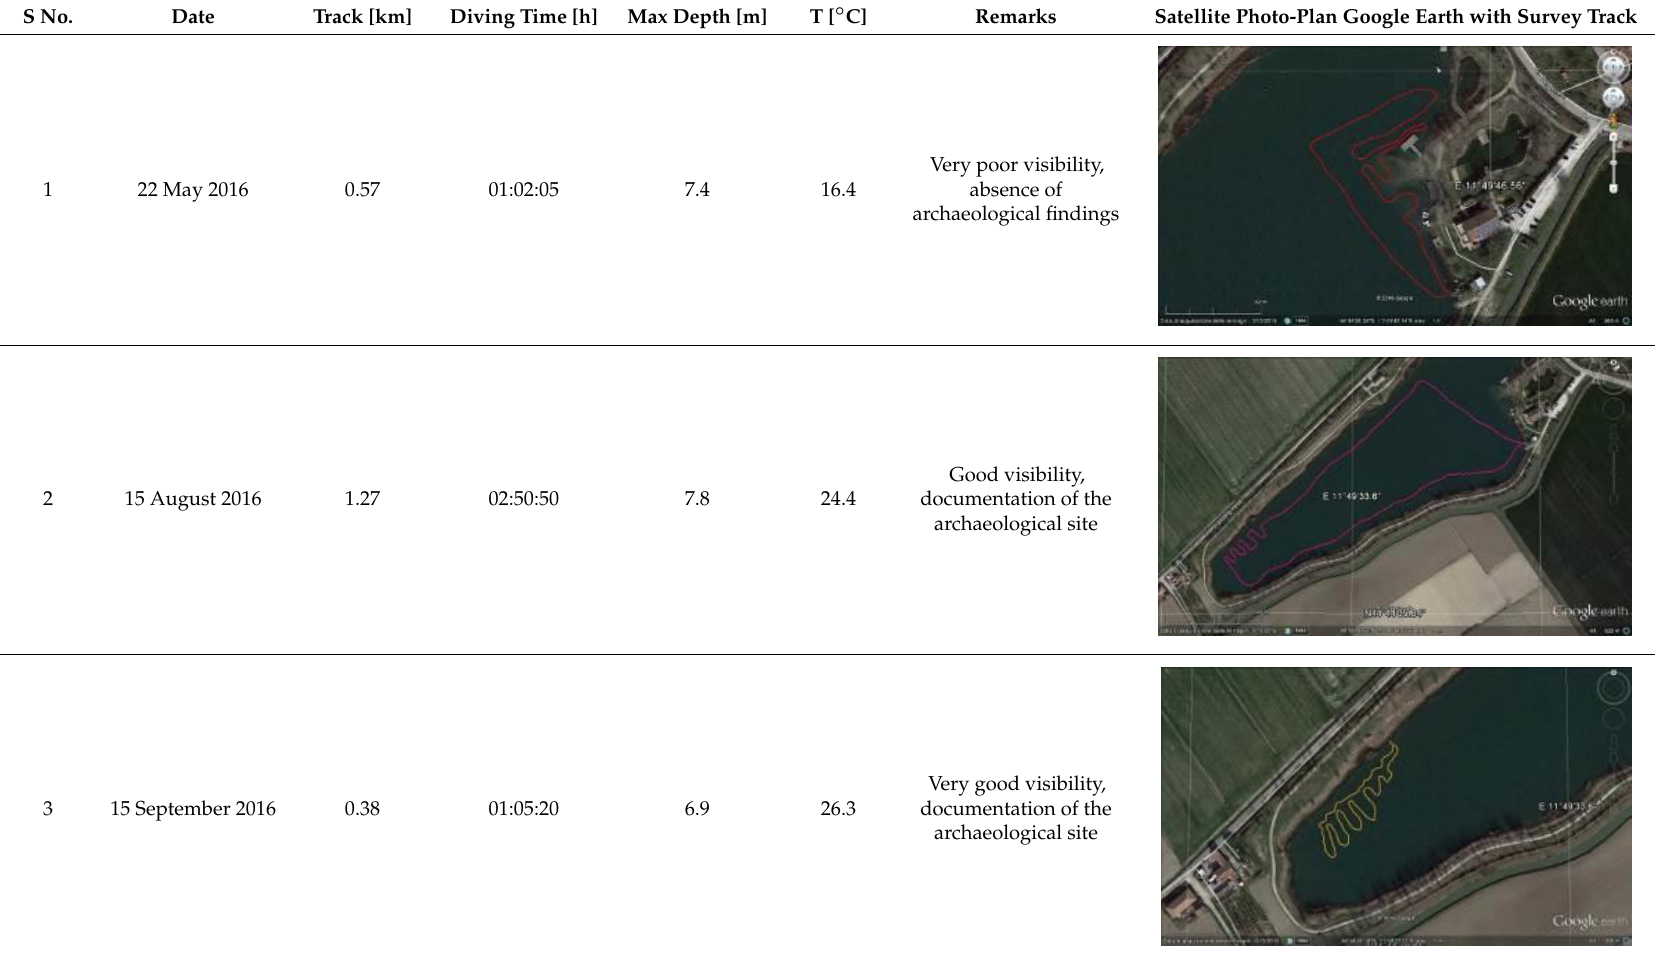
Table 1. The underwater surveys recording sheet, which includes the number of the survey, date, length of the track, diving time, maximum depth, temperature of the water, remarks, and Google Earth GPS mapping of the